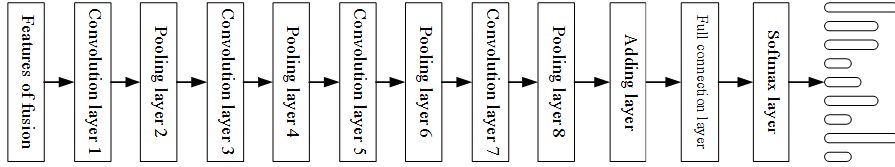
Figure 3. Network structure of malicious code detection based on